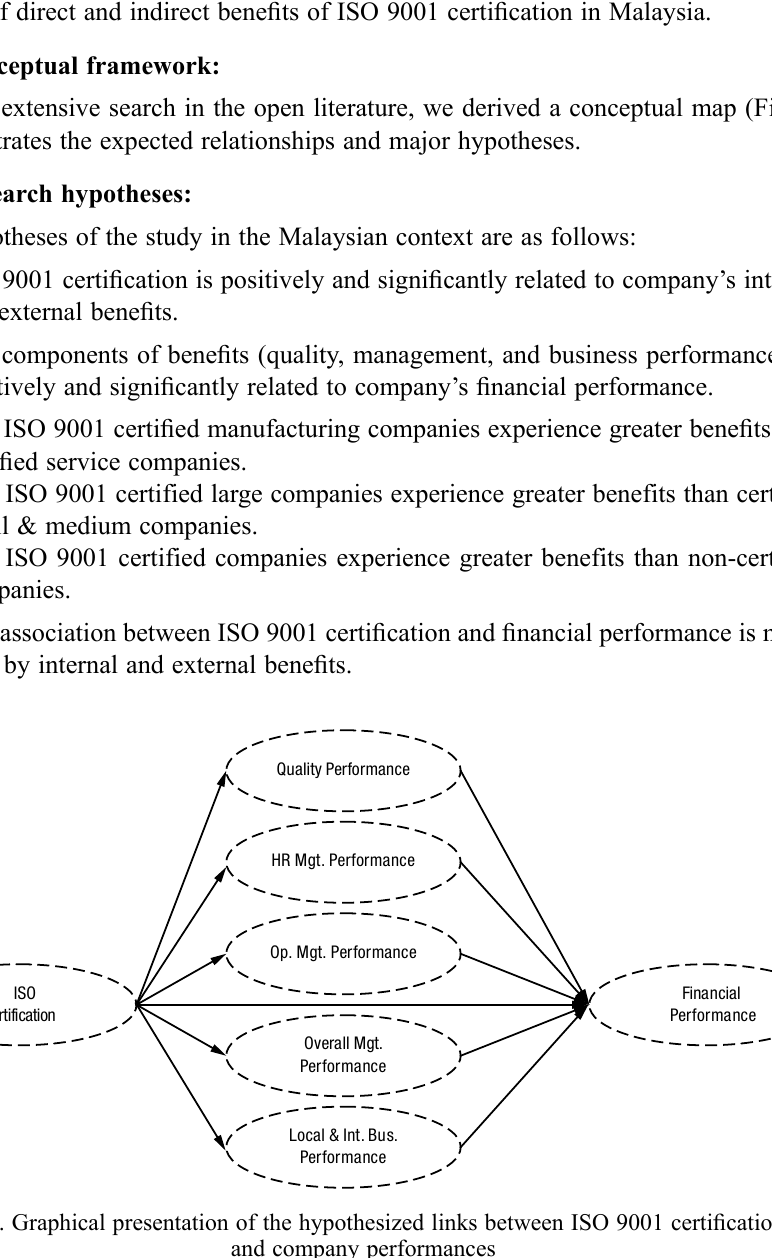
Fig. 1. Graphical presentation of the hypothesized links between ISO 9001 certification and company performances